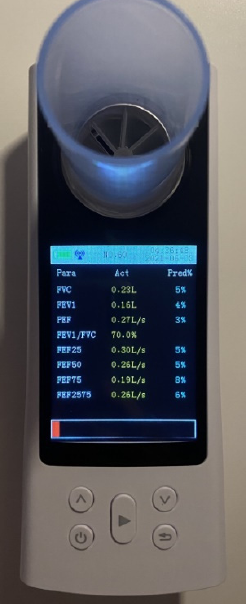
Figure 4. SP80B spirometer, Contec Medical Systems.